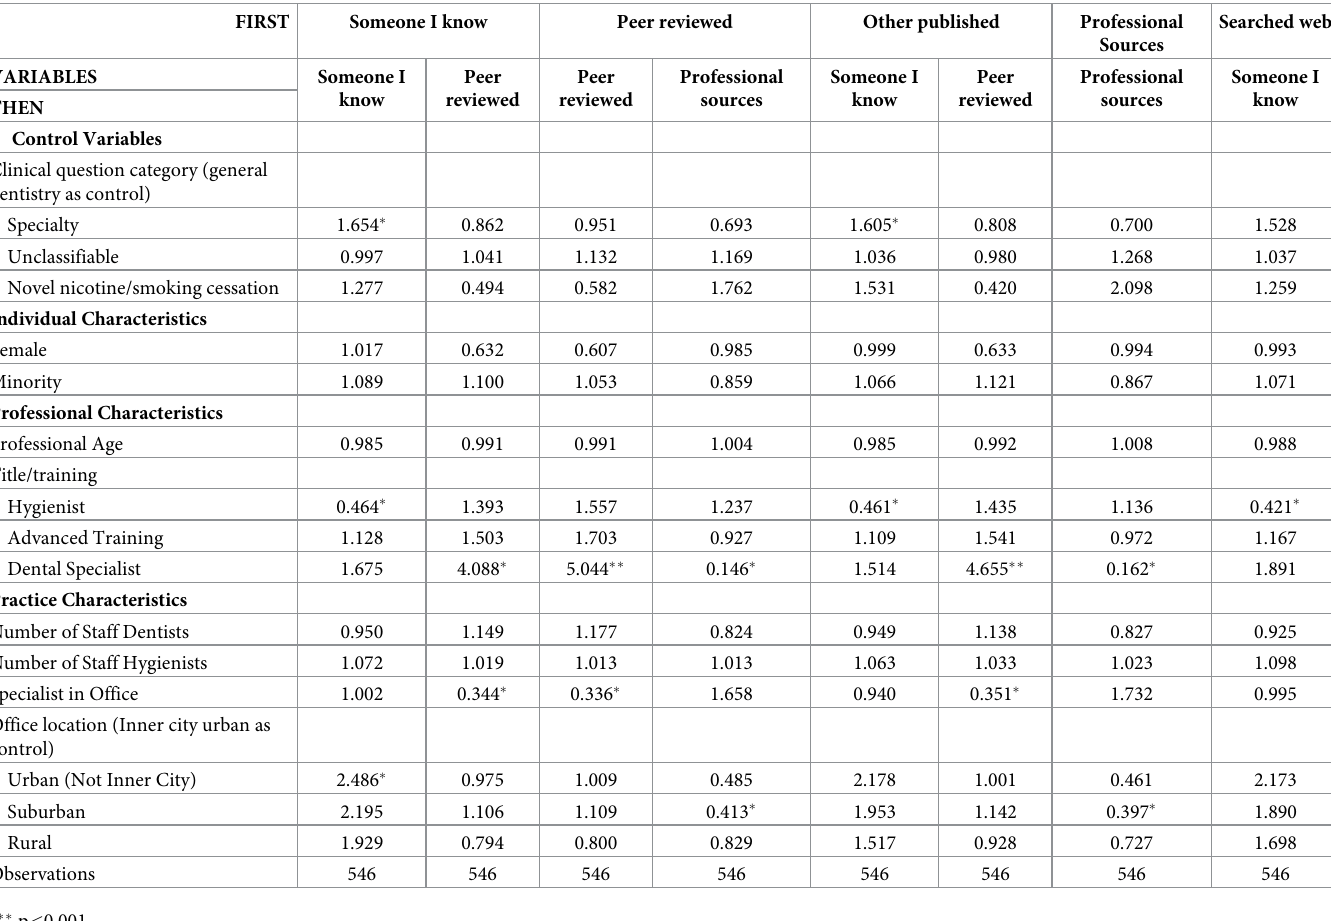
Table 3. Conditional logits of second level search patterns based on first search source for self-nominated clinical topics (odds ratios